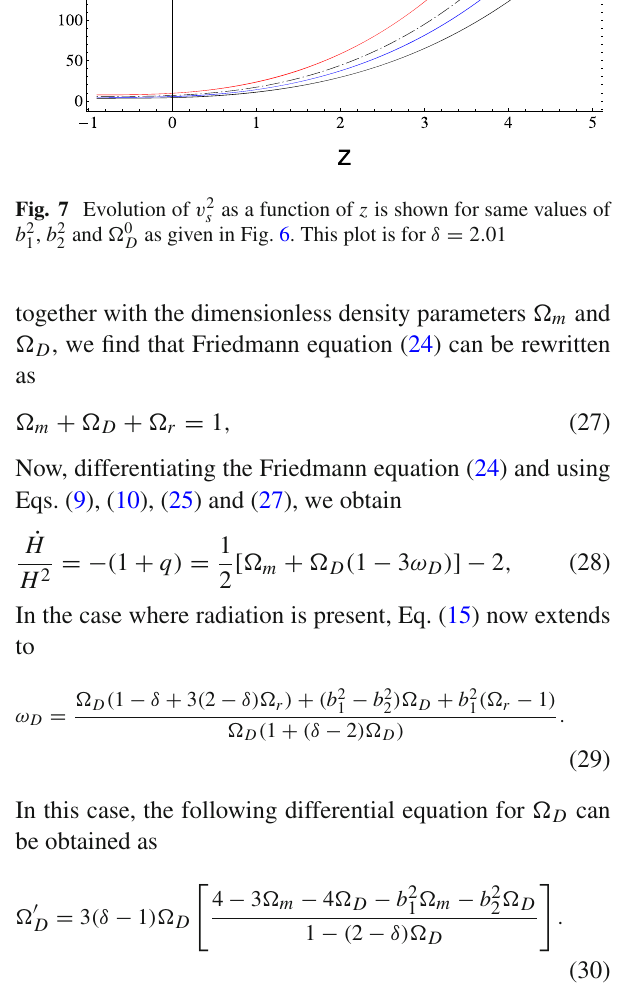
Fig. 6 Evolution of v 2 s as a function of z is shown for δ = 1 . 4, (cid:5) 0 0 . 73 and different values of b 2